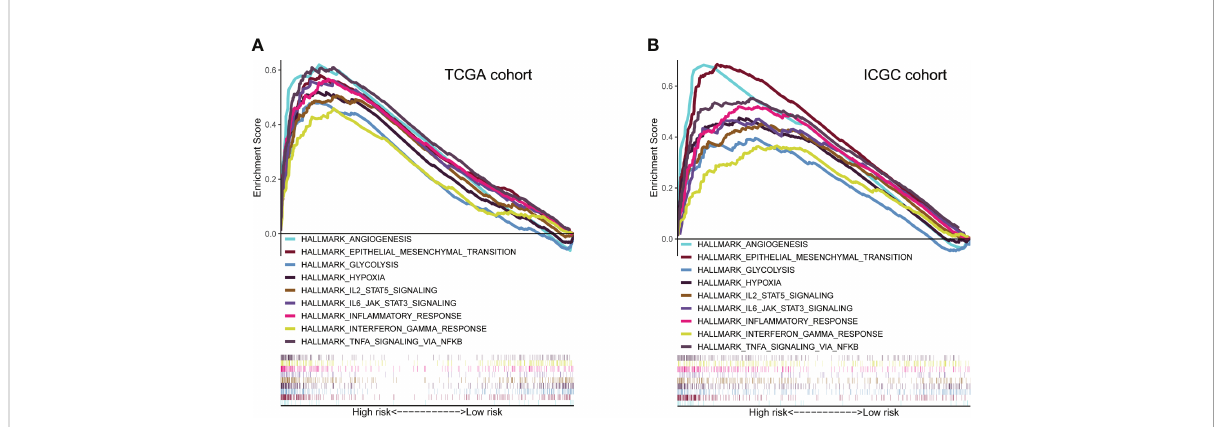
FIGURE 6 Molecular characteristics and biological function analysis. (A, B) Gene set enrichment analysis of biological functions and pathways in the risk score groups (P< 0.05, FDR< 0.25).